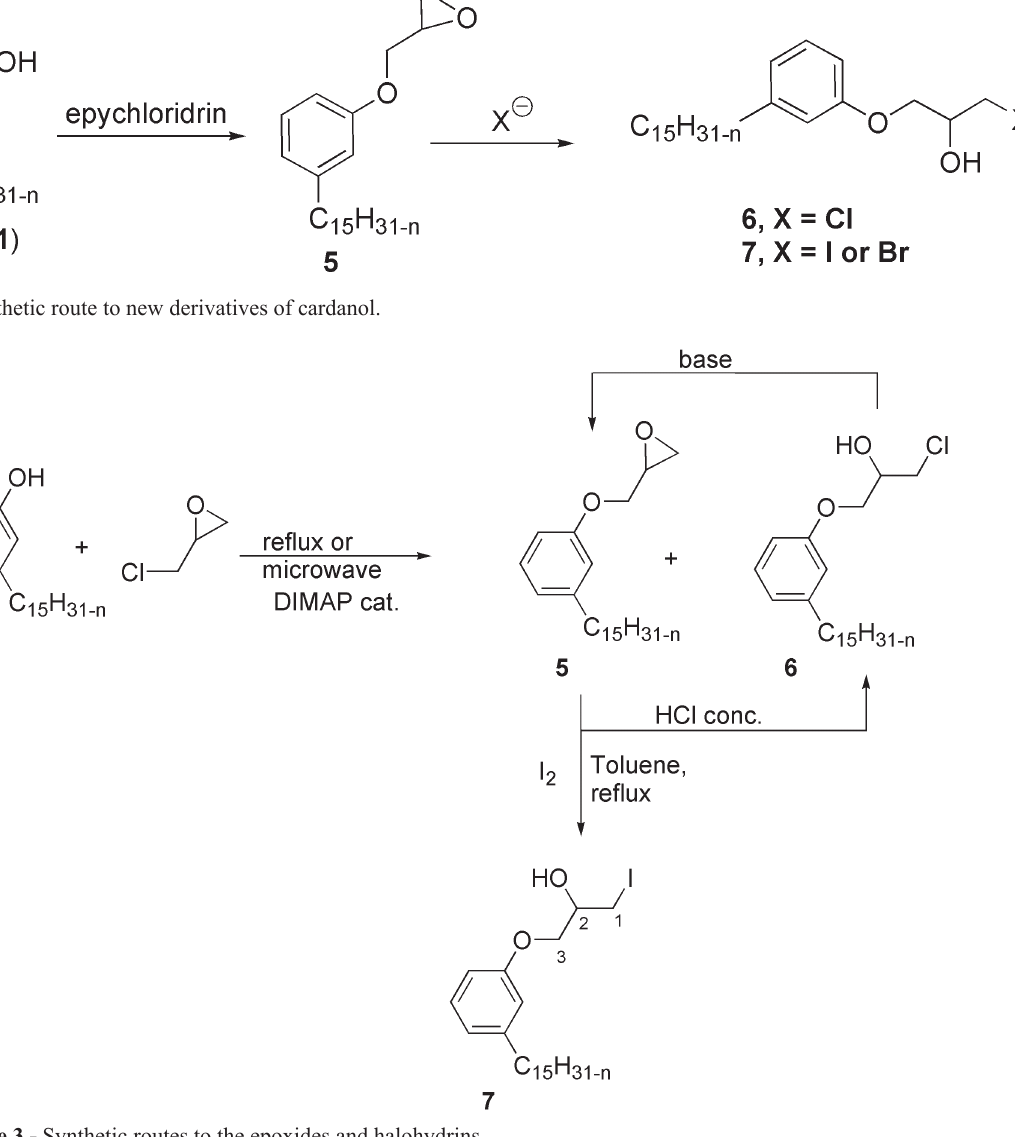
Figure 3 - Synthetic routes to the epoxides and